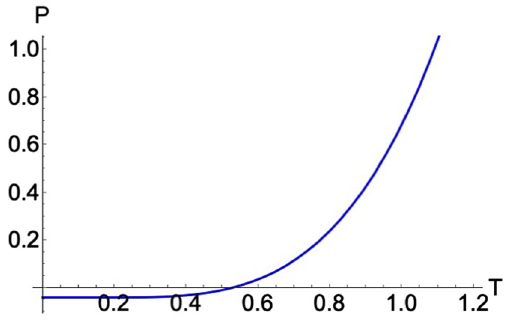
Fig. 13 Quantum vacuum pressure as a function of the temperature for Neumann/Dirichlet boundary conditions and for L = 1